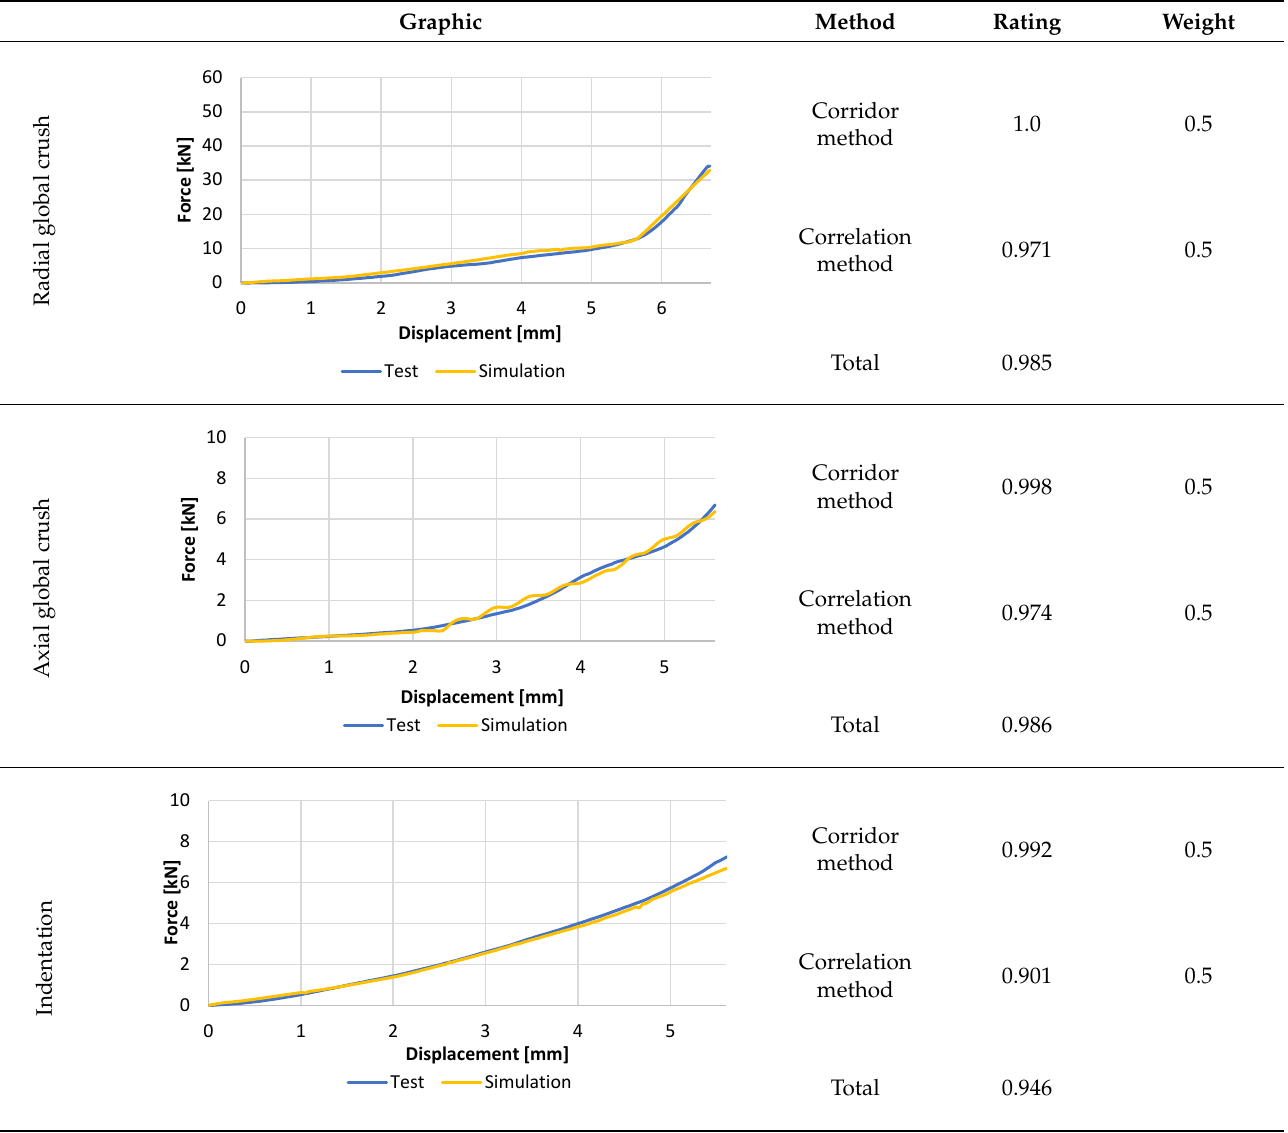
Table A2. Comparison of the force-displacement curves of the FE model and experimental tests for cell B and results of the CORA evaluation. Graphic